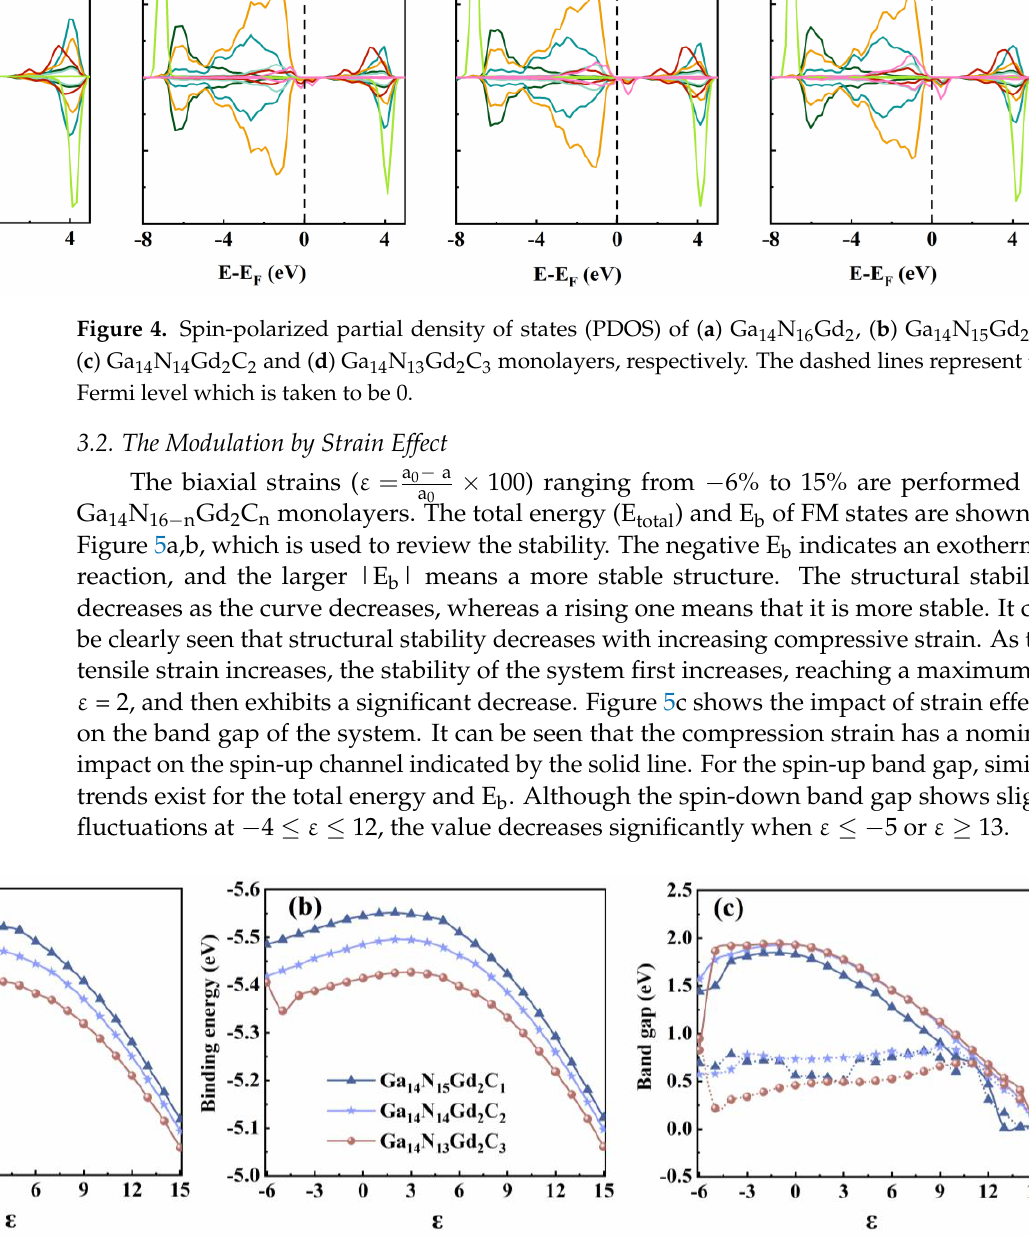
Figure 5. ( a ) E total of FM phase, ( b ) E b and ( c ) band gap of Ga 14 N 16 − n Gd 2 C n monolayers. The dark blue (triangle), light blue (pentagram) and brown (circle) lines in the diagram represent Ga 14 N 15 Gd 2 C 1 , Ga 14 N 14 Gd 2 C 2 and Ga 14 N 13 Gd 2 C 3 monolayers, respectively.